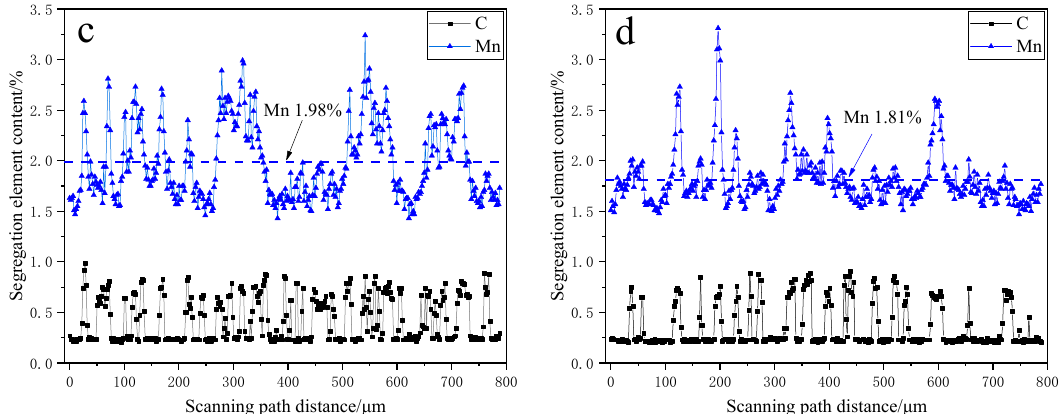
Figure 4. Segregation element content measured by EPMA line scanning in the segregation region of steel: ( a , c ) Steel 1; ( b , d ) Steel 2.